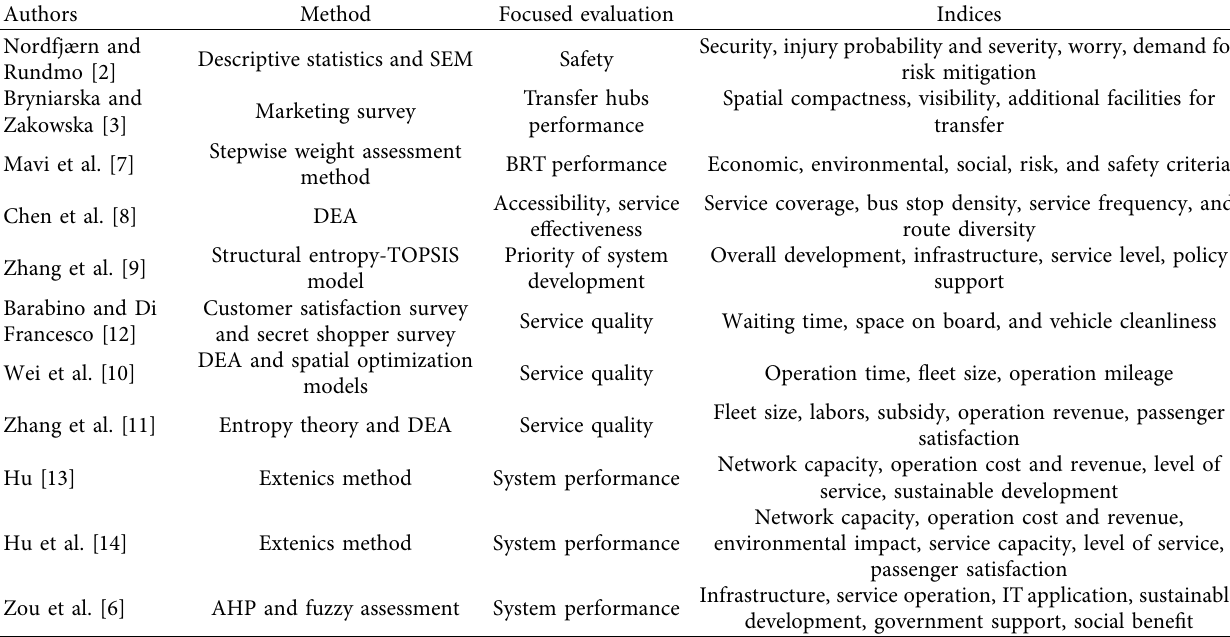
Table 1: Previous studies on bus transit